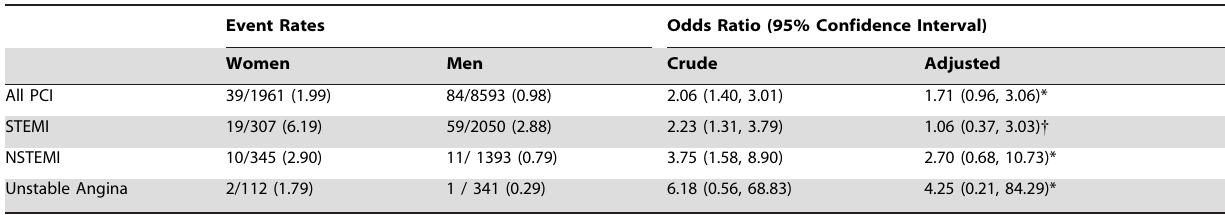
Event Rates Odds Ratio (95% Confidence Interval) Women Men Crude